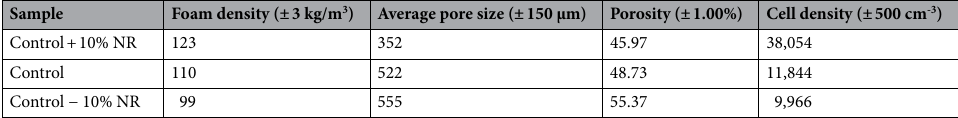
Table 2. Foam density, average pore size, porosity, and cell density of various foam samples.